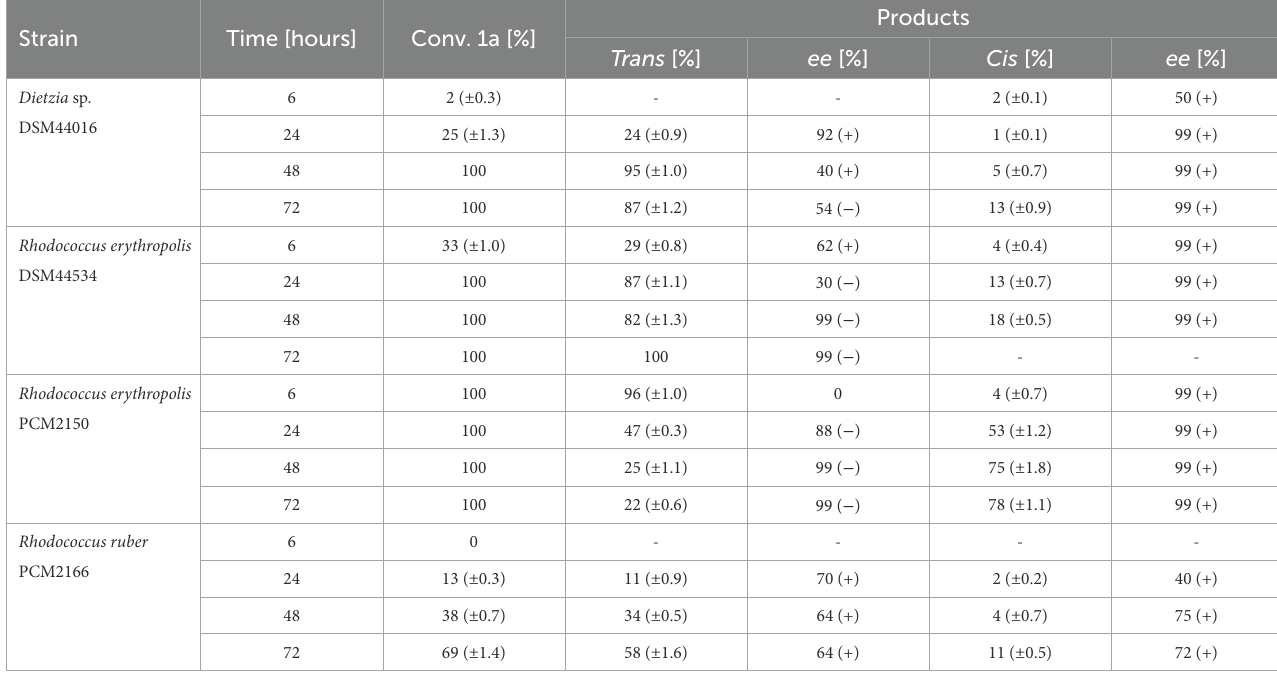
%, determined by CGC.